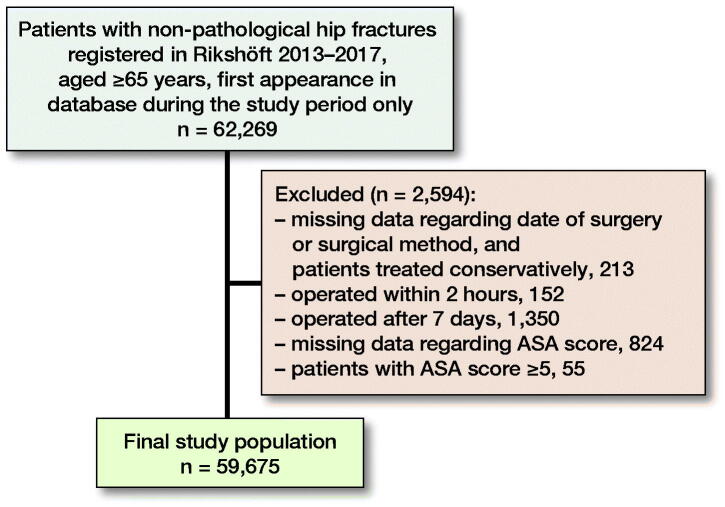
Flowchart of the study population.